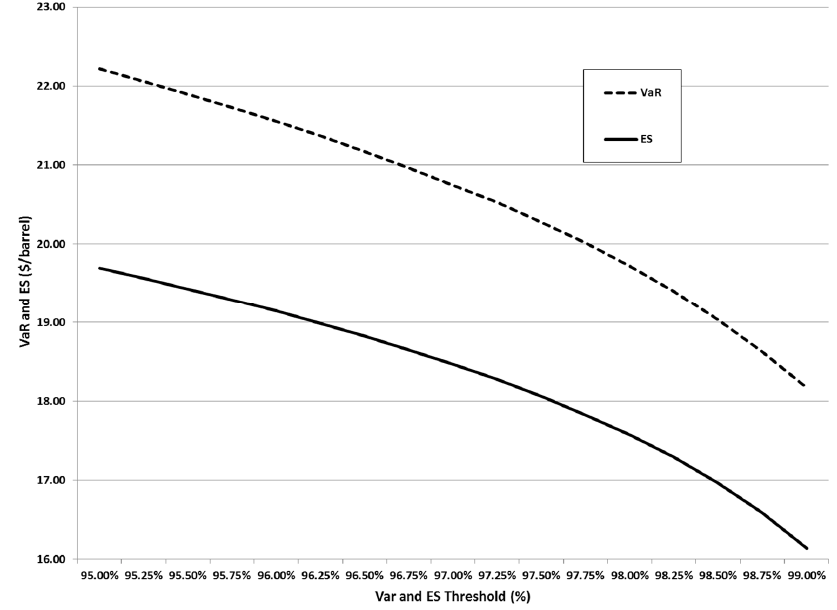
Figure 8. Revenue VaR and ES as a function of the probability cut ‐ off threshold.